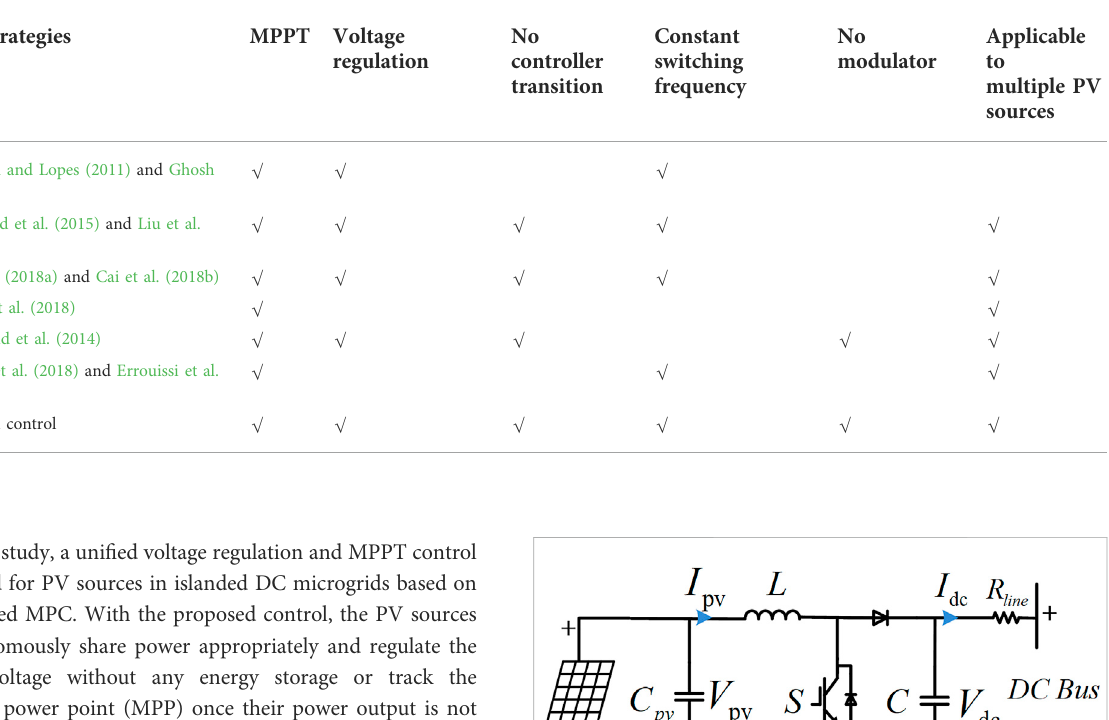
TABLE 1 Comparison of control strategies.